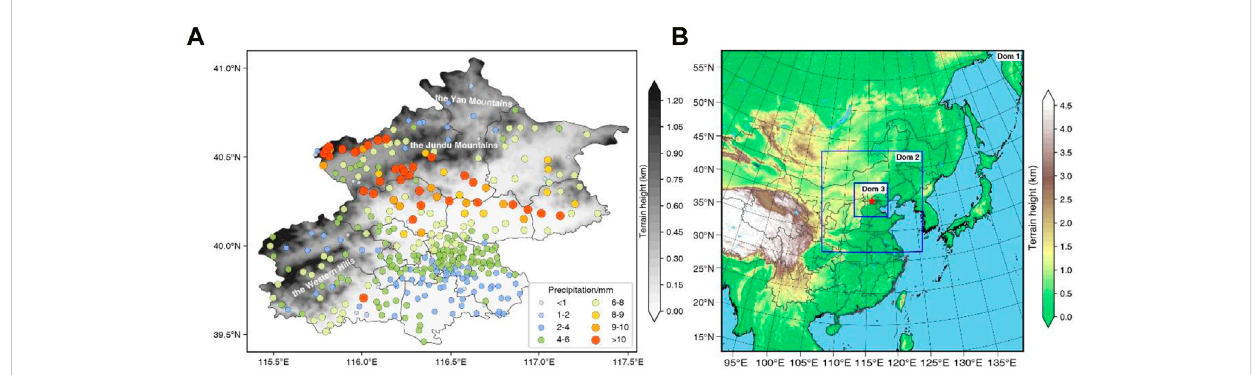
FIGURE 1 (A) Observed 24-h accumulated precipitation (colored scatter points, unit: mm) and terrain height (shading, unit: km) in the Beijing area from 1800 UTC on February 12 to 1800 UTC on February 13, 2022. (B) Domain con fi guration of the simulation and terrain height (shading; unit: km). Red asterisk indicates the location of the center of the domain.